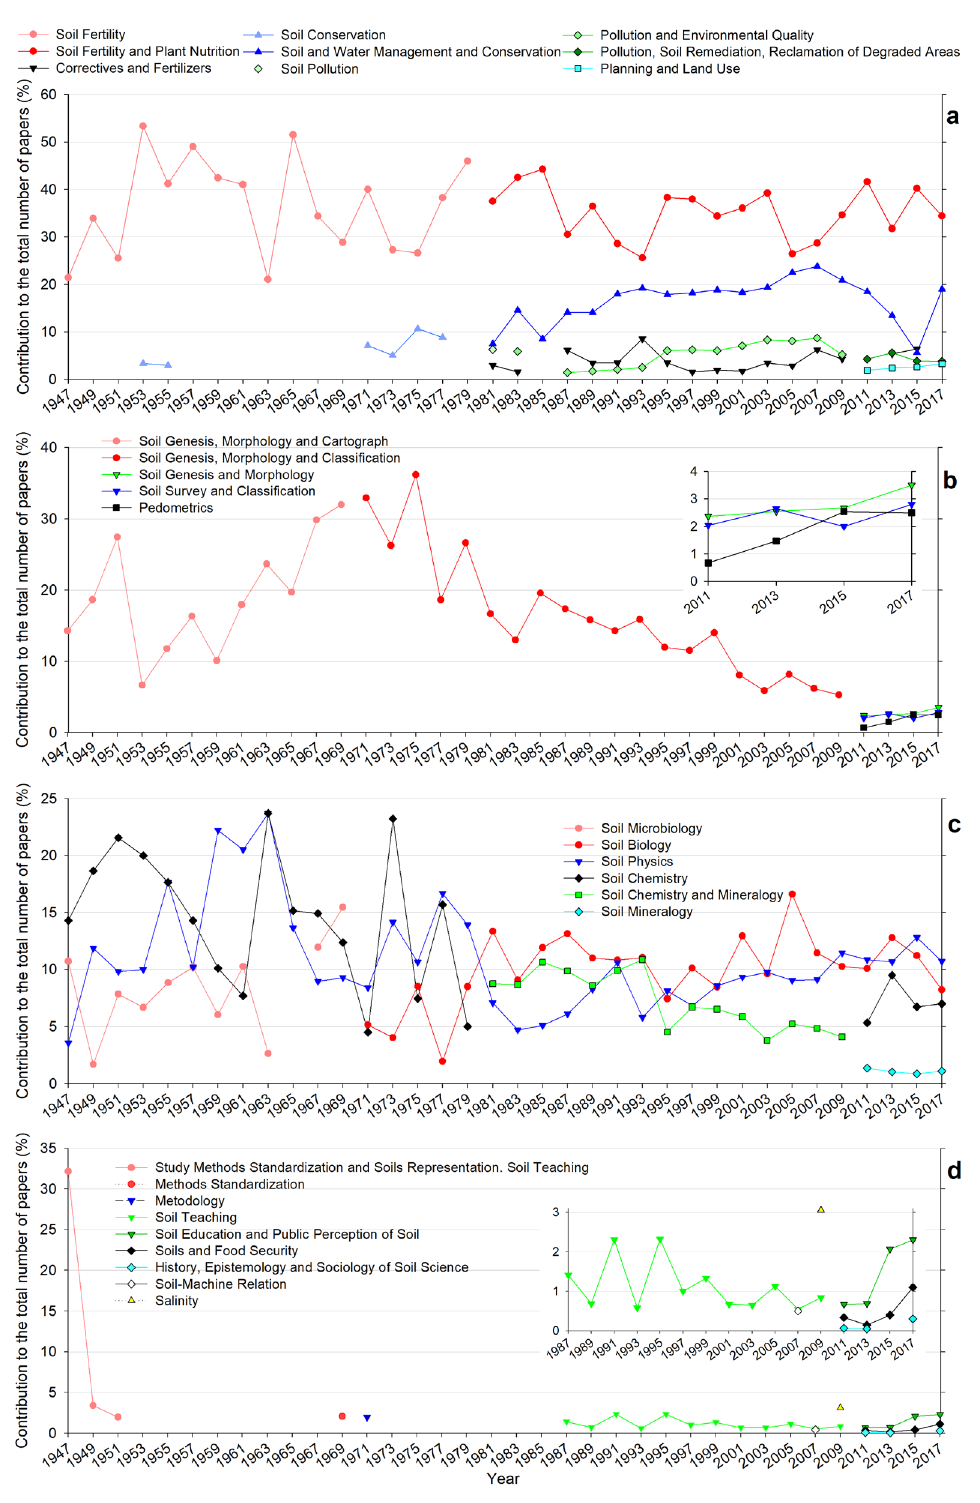
Figure 2. Contribution of thematic areas to the total number of papers published at the Brazilian Congress of Soil Science (Congresso Brasileiro de Ciência do Solo - CBCS) between 1947 and